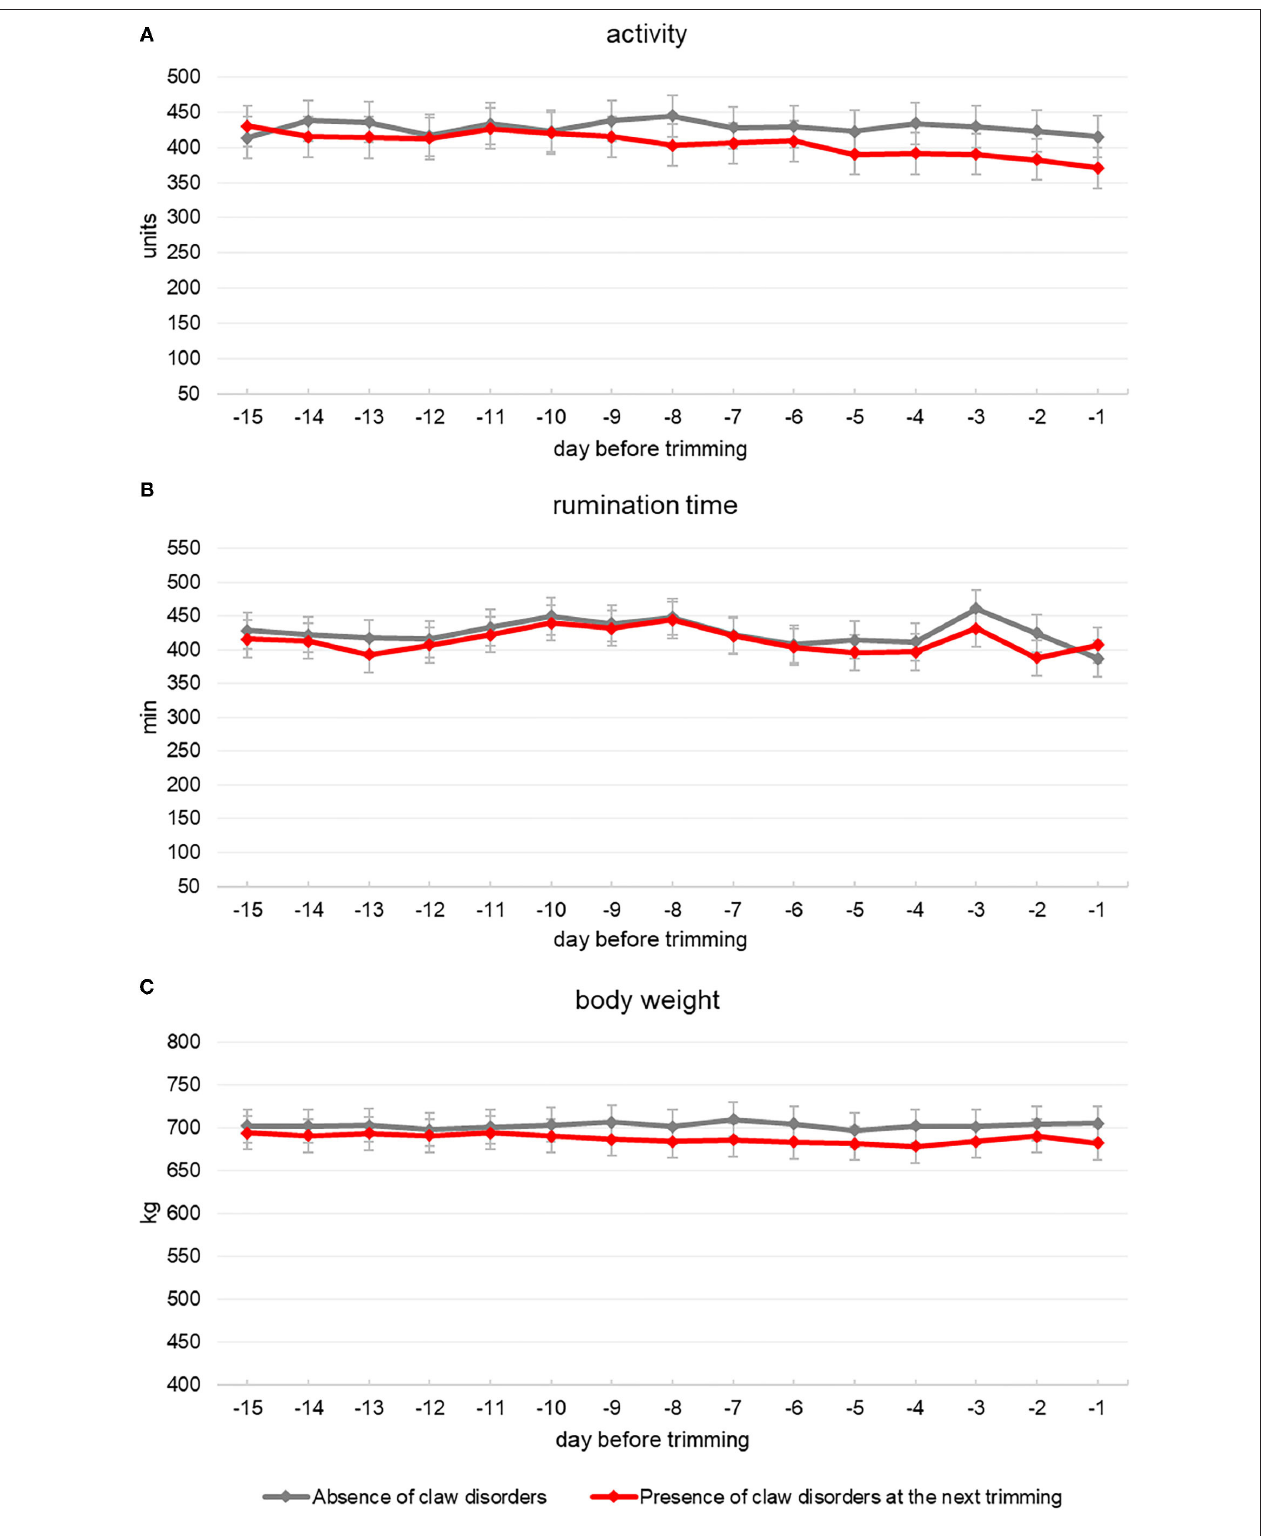
FIGURE 1 | Daily activity (A) , rumination time (B) , and body weight (C) patterns of 15 Italian Holstein multiparous cows over the 15 days that preceded two following hoof trimming practices in which they were diagnosed with no claw disorders (gray line) or affected by claw disorders (red line), respectively.